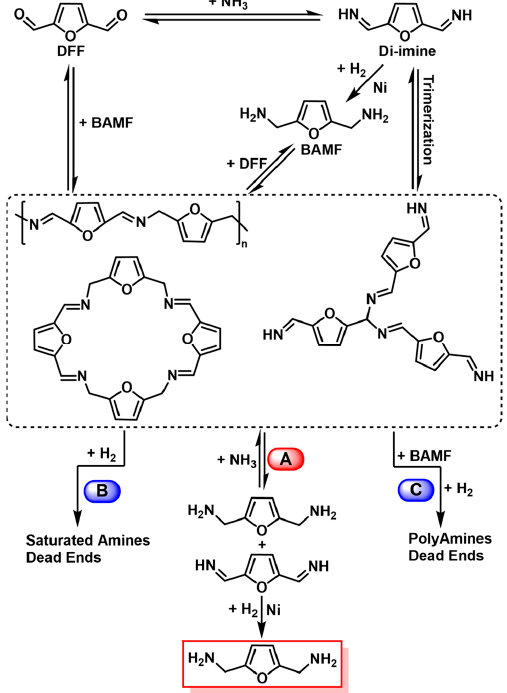
Scheme 3. Proposed reaction intermediates for the formation of BAMF with macrocyclic and linear polymers during the reductive amination of DFF. Adapted with permission from ref. [93].